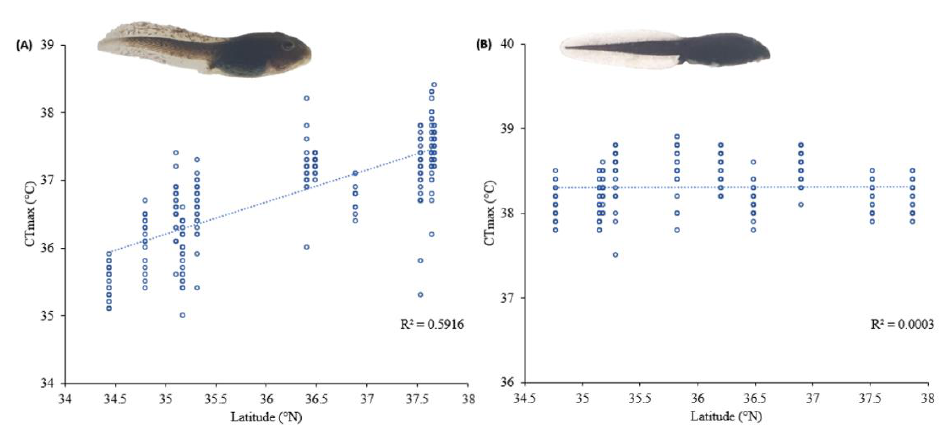
Figure 3. The relationship between latitude and critical thermal maximum (CTmax) in Rana uenoi ( A ; n = 270) and Bufo sachalinensis ( B ; n = 240). There was a significant positive relationship between (( A ); n = 270) and Bufo sachalinensis (( B ); n = 240). There was a significant positive relationship between latitude and tadpoles ’ CTmax in R. uenoi . latitude and tadpoles’ CTmax in R. uenoi